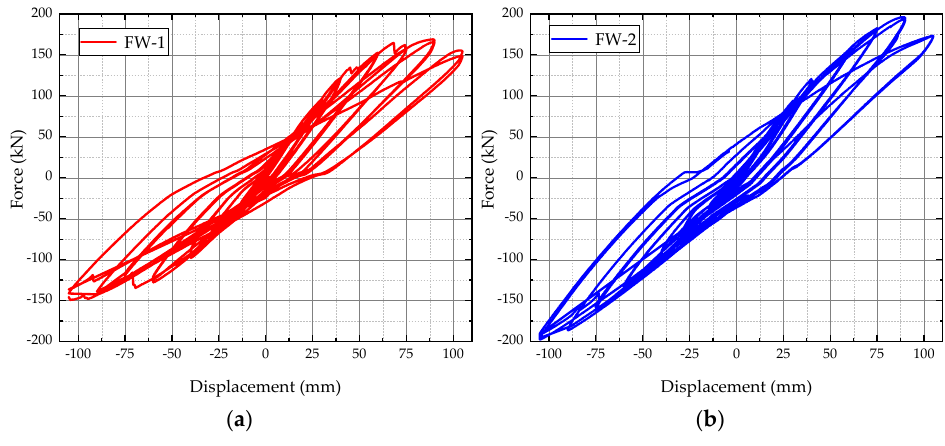
Figure 14. Hysteresis curves of FW-1 ( a ) and FW-2 ( b ).